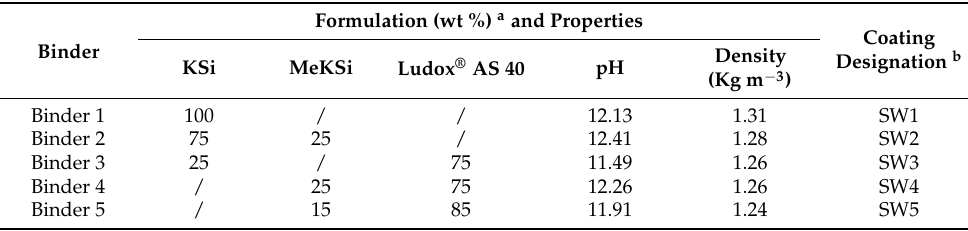
Table 2. Formulation of the binders and coating